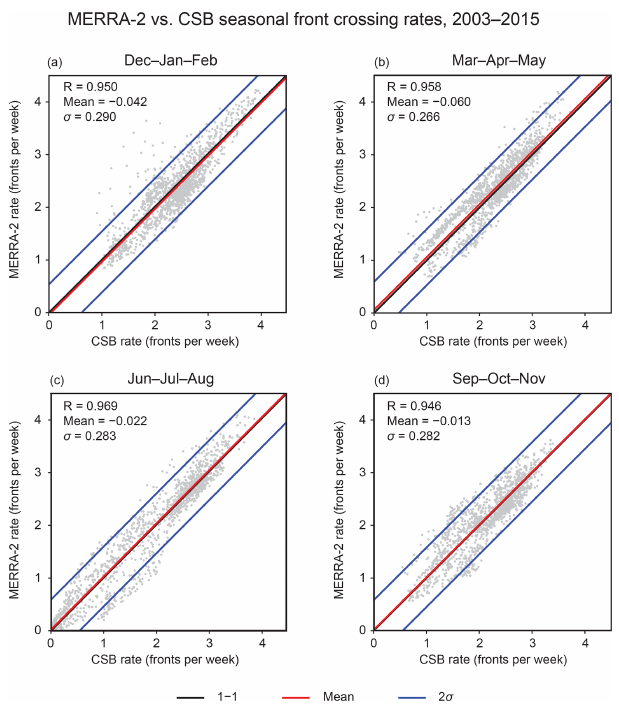
Figure 7. Scatter plots comparing the DL-FRONT and CSB sea- sonal front rate climatologies over the CONUS-centered ROI.